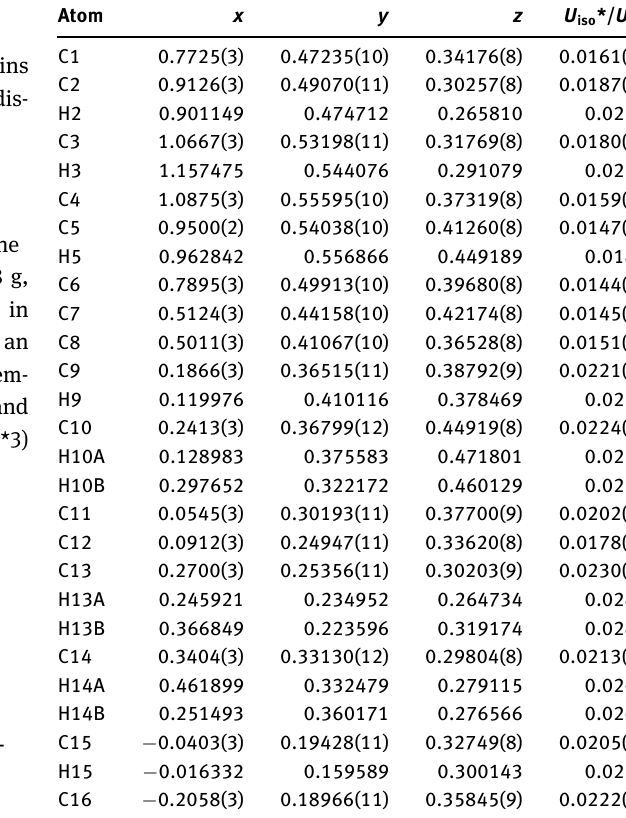
Table 2: Fractional atomic coordinates and isotropic or equivalent isotropic displacement parameters (Å 2